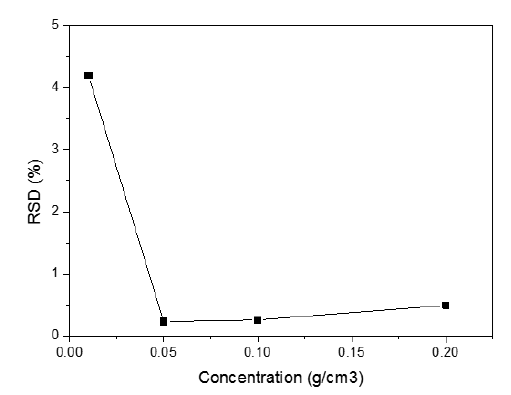
Fig. 2. Relative Standard Deviation (RSD) for each